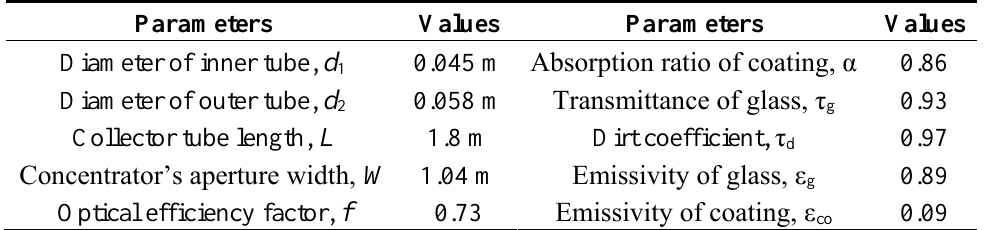
Table 2. Design parameters used for the theoretical calculations and the experimental